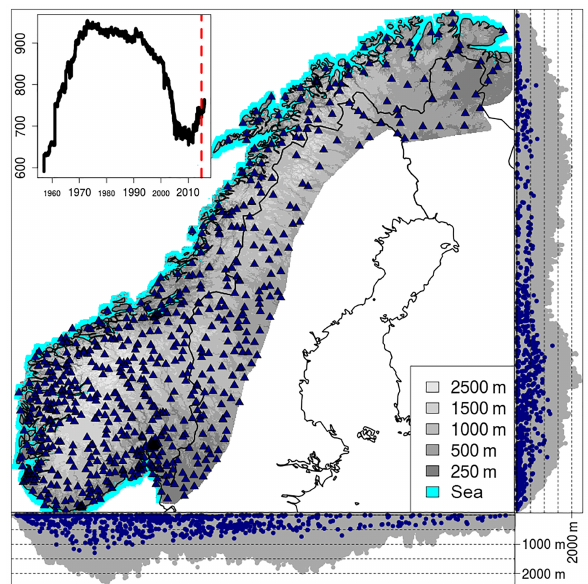
Figure 1. seNorge2 domain, topography (gray shades, meters above mean sea level) and station locations (blue triangles, valid for the date: 24 November 2014). The total number of station locations in the example is 737. The top-left inset shows the time series for the number of available observations for the whole period covered by the dataset: 1957–2015; the red line marks the day 24 November 2014. The two lateral panels show the distributions of elevations for both the digital elevation model (gray dots) and stations (blue dots) along the Easting (bottom panels) and Northing (lateral panel)